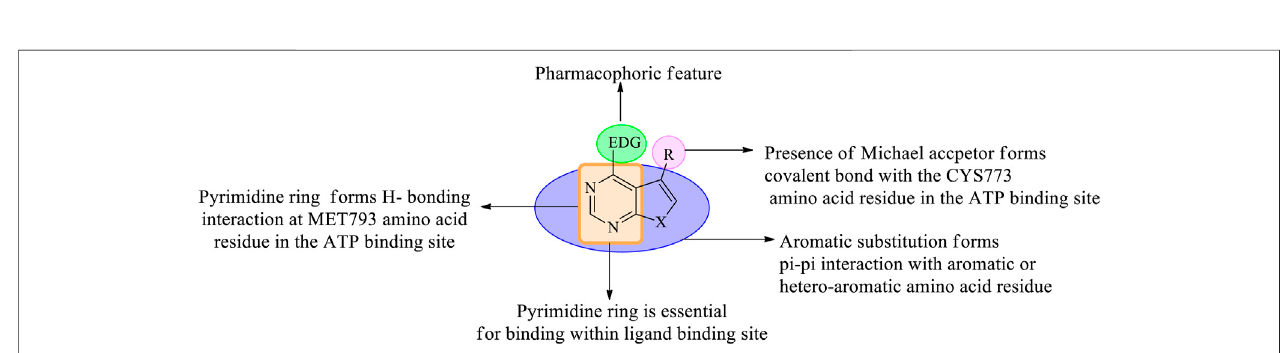
FIGURE 22 | Computational aspects of fused pyrimidine as EGFR inhibitor.